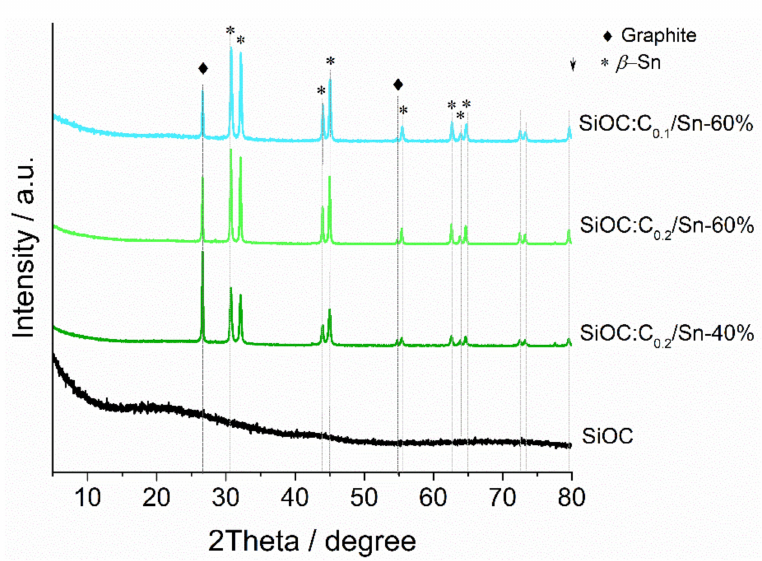
Figure 2. Diffractograms of SiOC and ternary composite